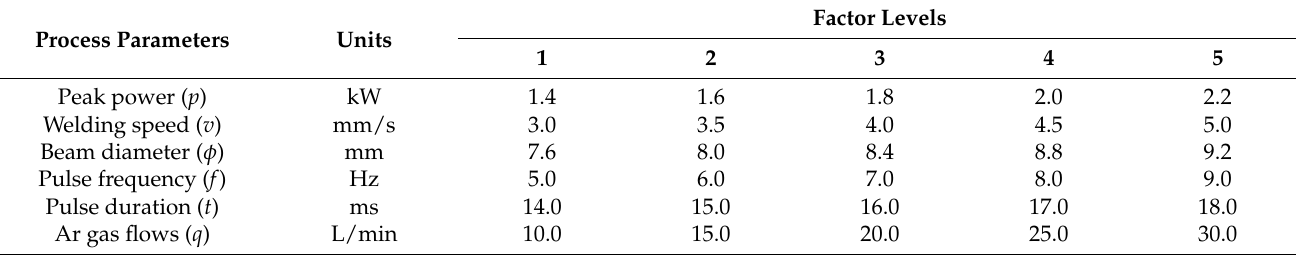
Table 2. The laser parameters and their levels for welding PMMA–steel.